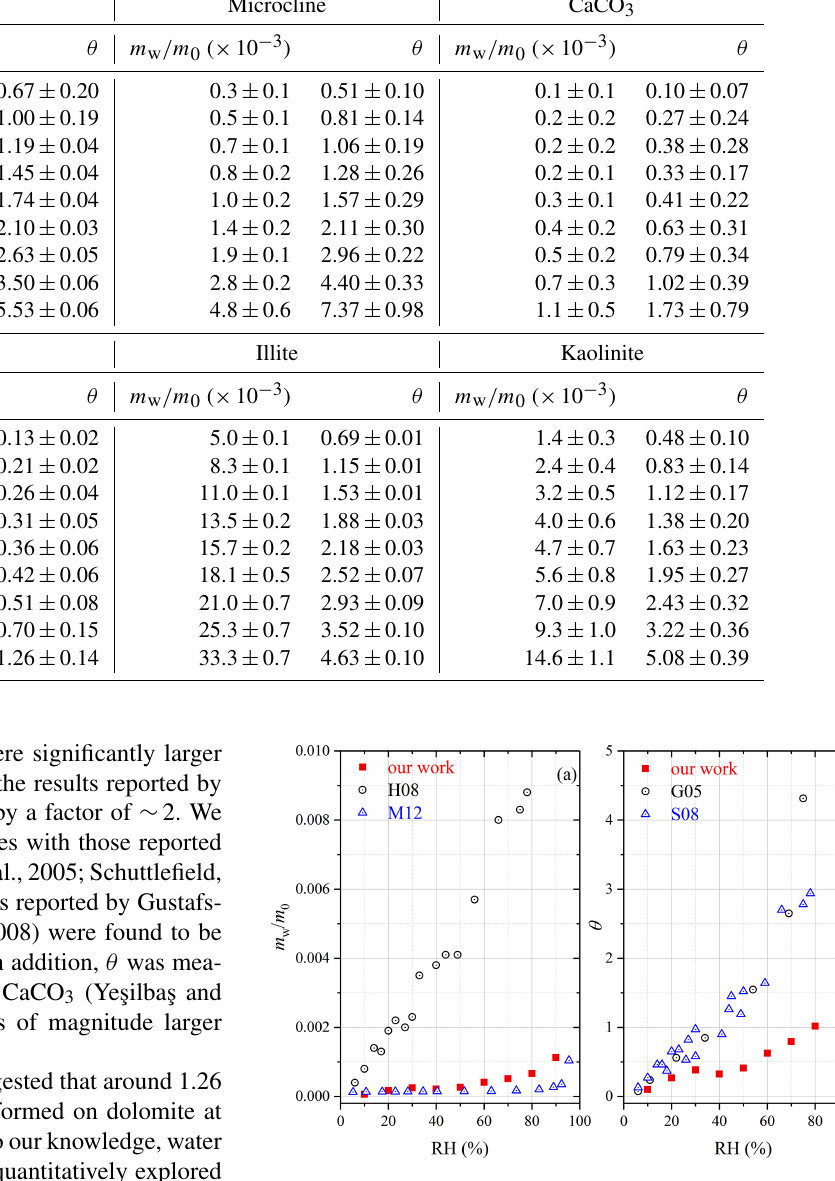
Figure 5. Comparison of water adsorption on CaCO 3 examined in different studies: (a) mass ratios of adsorbed water to the dry min- eral ( m w /m 0 ); (b) surface coverages of adsorbed water ( θ ). G05, Gustafsson et al. (2005); H08, Hatch et al. (2008); S08, Schuttle- field (2008); M12, Ma et al.